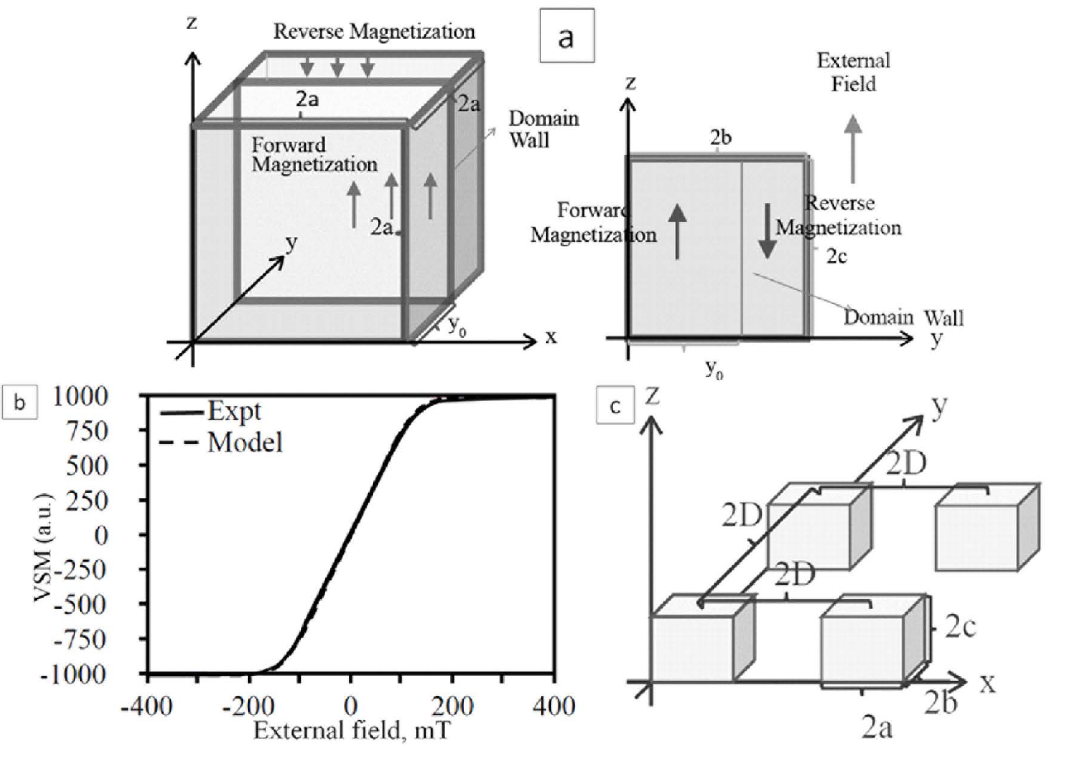
Figure 5. Schematic of domain wall position (a), comparison between model and experiment (b), and schematic of arrays on sample plane (c).